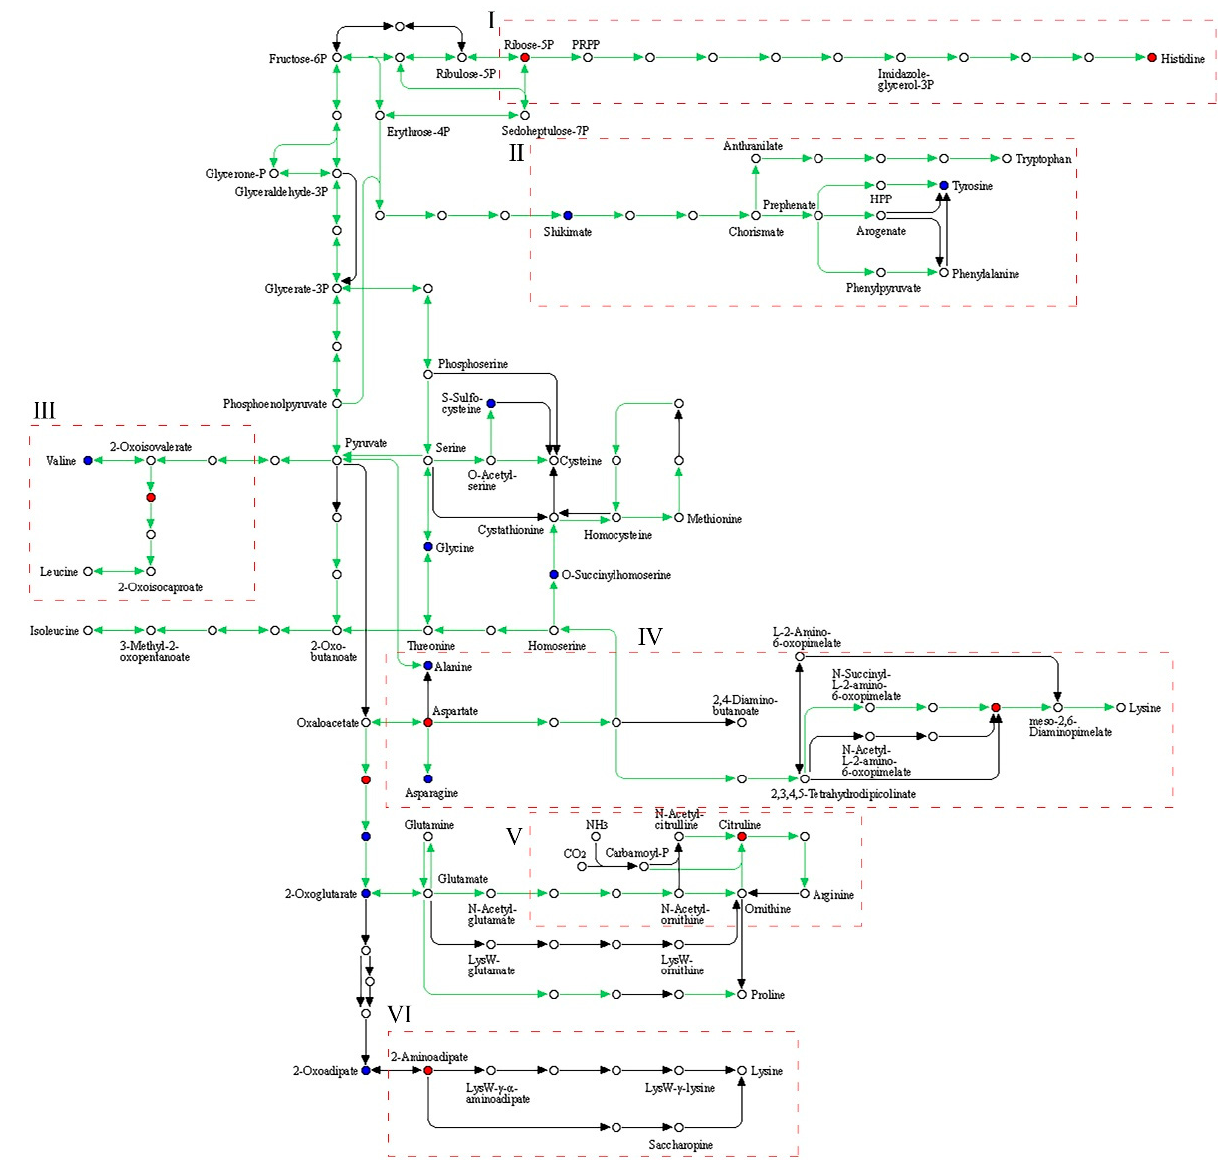
Figure 5. Biosynthesis of amino acids metabolic pathway (p0 vs. p3). Red and green dots represent the upregulation and downregulation of metabolites, respectively. I, II, III, IV, V, and VI represent the histidine metabolic pathway, tyrosine metabolic pathway, valine metabolic pathway, lysine metabolic pathway, arginine metabolic pathway and lysine metabolic pathway.